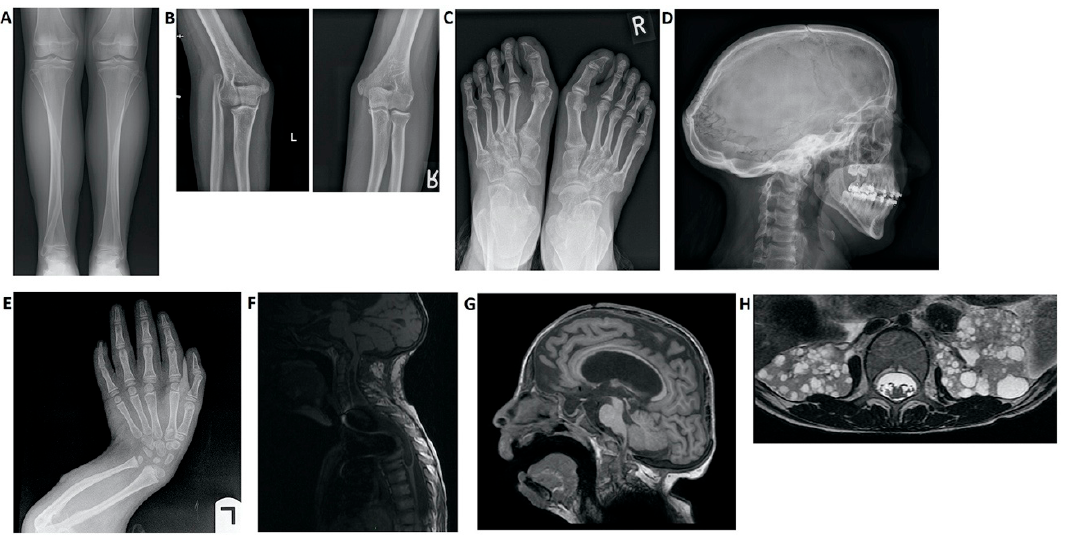
Figure 4. Imaging findings in patients with Hajdu–Cheney syndrome. ( A ) Radiograph of the frontal view of the tibia and fibula. Note the elongated and medially deviated fibula, superposing the tibia bone, referred to as a “serpentine fibula.” ( B ) Radiographs of the lateral view of the left arm showing dislocation of the radial head. ( C ) Radiograph of the frontal view of the feet showing hallux valgus, crowded metatarsal bones, short foot distal digits, and acroosteolysis signs at distal phalanges of the first digit. ( D ) Radiograph of the lateral view of the skull, demonstrating batrocephaly, frontal sinuses hypoplasia, and multiple occipital wormian bones. ( E ) Radiograph of the frontal view of the hands, showing crowded metacarpal bones, short hand distal digits, and acroosteolysis signs at the distal phalanges. ( E ) Radiograph of the lateral view of the arm, showing shortening of the distal fingers and long bones of the arm, and a curved radius and ulna. ( F ) Spinal MRI showing deformations of the cervical spine, as well as a significant syrinx of the cord. ( G ) Brain MRI. Note the ventricular enlargement with a VP (ventriculo-peritoneal) shunt, frontal hypoplasia of the sinuses, and a small foramen magnum. ( H ) Abdominal MRI showing multiple bilateral kidney cysts.